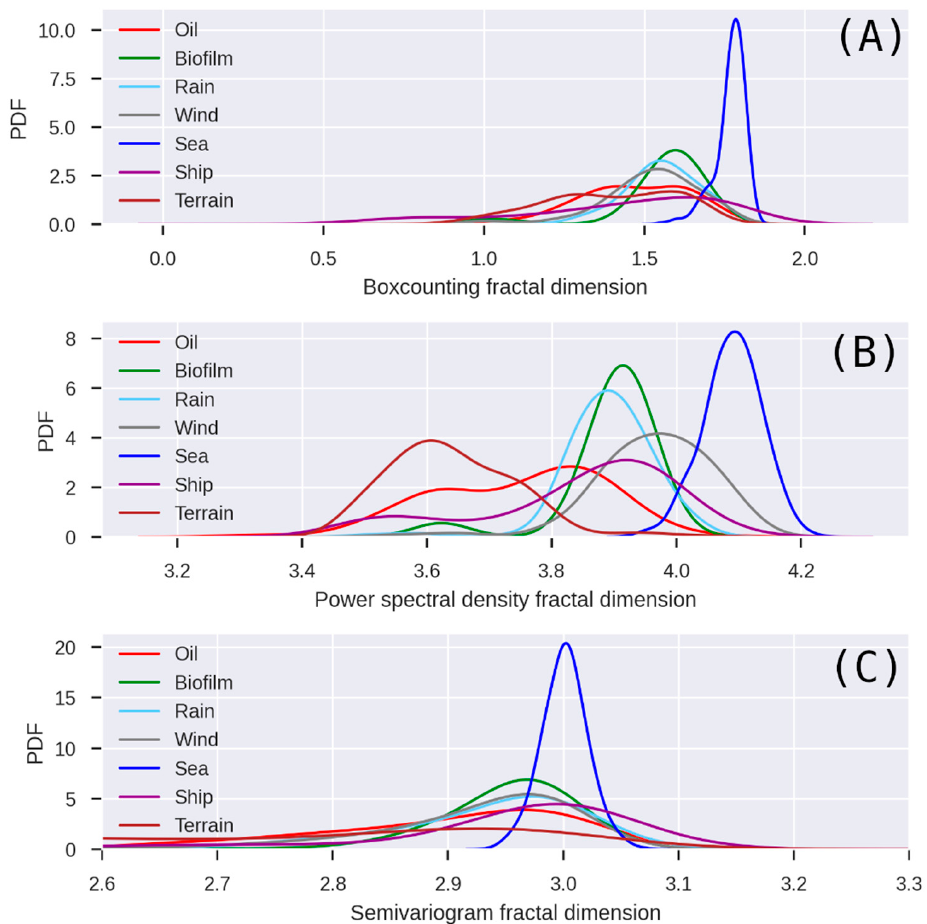
Figure 3. Probability density functions (PDFs), relative likelihood curves with the normalized area calculated for three different fractal dimension distributions: box counting ( A ), power spectral ( B ), and semivariogram ( C ).